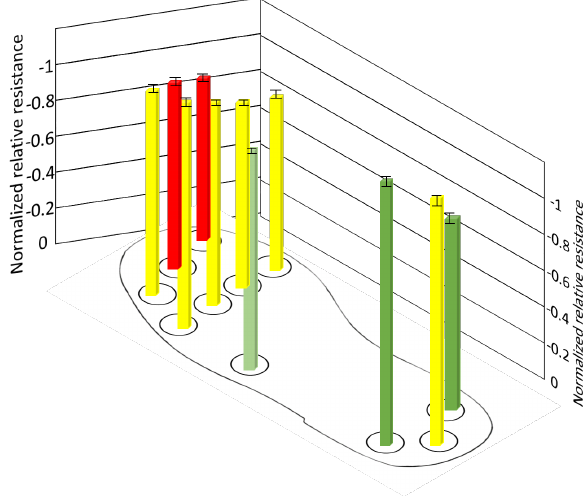
Figure 14. Normalized resistance of sensors during position B.